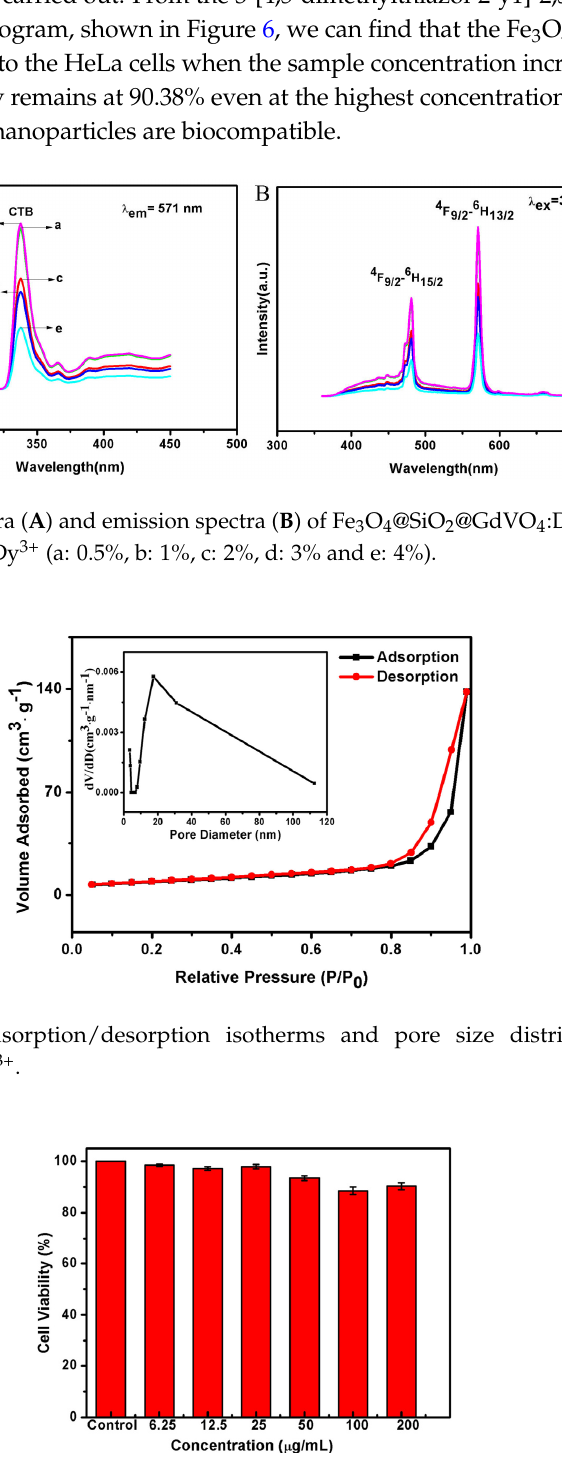
Figure 6. The viability histograms of HeLa cells incubated with different concentrations of Fe 3 O 4 @SiO 2 @GdVO 4 :Dy 3+ nanoparticles for measured